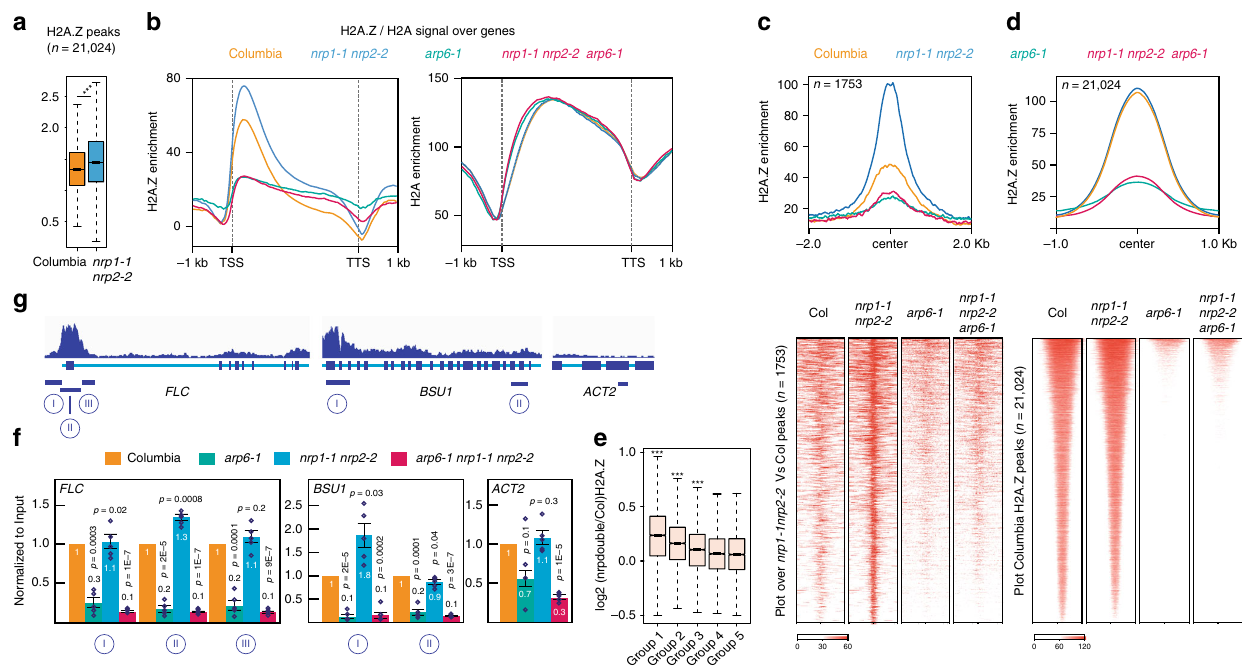
Fig. 3 nrp1-1 nrp2-2 double mutants display overaccumulation of H2A.Z. a Boxplot of log2 ratio of H2AZ/Input in Columbia and nrp1-1 nrp2-2 over H2A.Z peaks de fi ned in Columbia. *** indicates p -value of <2.2e − 16 (Two-tailed paired Student ’ s t test). b Metaplot of H2A.Z/Input and H2A/Input in Columbia, nrp1-1 nrp2-2 , arp6-1 , and arp6-1 nrp1-1 nrp2-2 over the gene body. c Plot and heatmap of Columbia, nrp1-1 nrp2-2 , arp6-1 , and nrp1-1 nrp2-2 arp6-1 over nrp1-1 nrp2-2 dependent H2A.Z peaks ( n = 1753). d Plot and heatmap of H2A.Z peaks ( n = 21,024) in Columbia, nrp1-1 nrp2-2 , arp6-1 , and nrp1-1 nrp2-2 arp6-1 . e Boxplot showing the divergence of H2A.Z occupancy between Columbia and nrp1-1 nrp2-2 at different groups of genes divided according to increasing expression levels. Center lines indicate the median, boxes show the 25th (bottom) and 75th (top) percentiles; whiskers extend to the minima and maxima. *** Indicates a p -value of <2.2e − 16 , <2.2e − 16 , and 9.57e − 6 for Group 1, 2, and 3 respectively determined by two-tailed, paired Student ’ s t test. f The relative abundance of H2A.Z in Columbia, arp6-1 , nrp1-1 nrp2-2 , and arp6-1 nrp1-1 nrp2-2 measured by ChIP-PCR at FLC, BSU1 , and ACT2 . Error bars represent standard error from fi ve biological replicates. Two-tailed, paired Student ’ s t test was used to determine p -value. g The upper part of the p anel shows the distribution of H2A.Z ChIP reads across the genes immediately below. Schematic representation of the genes FLC, BSU1 , and ACT2 . Introns and exons are shown in light blue and navy blue, respectively. Roman numerals in f and g indicate the amplicon that was used by ChIP-qPCR analyses. Source data underlying Fig. 3a, e, f are provided as a Source Data fi